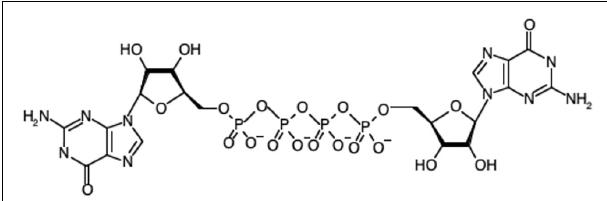
FIGURE 1 | The chemical structure of diadenosine tetraphosphate (Ap 4